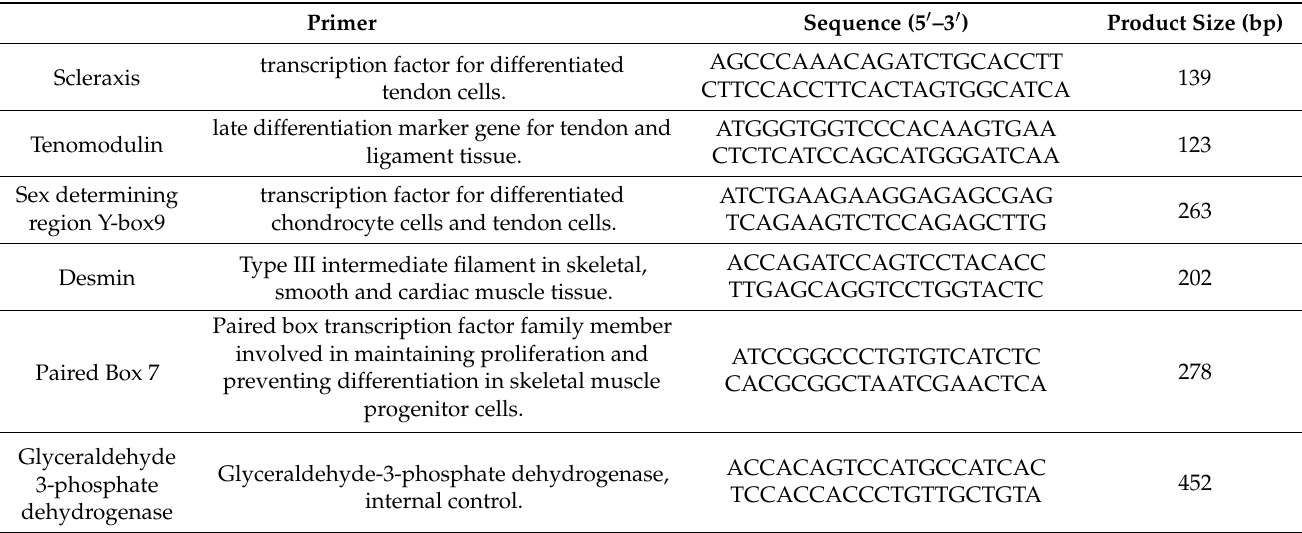
Table 2. Primer sequences and product sizes for